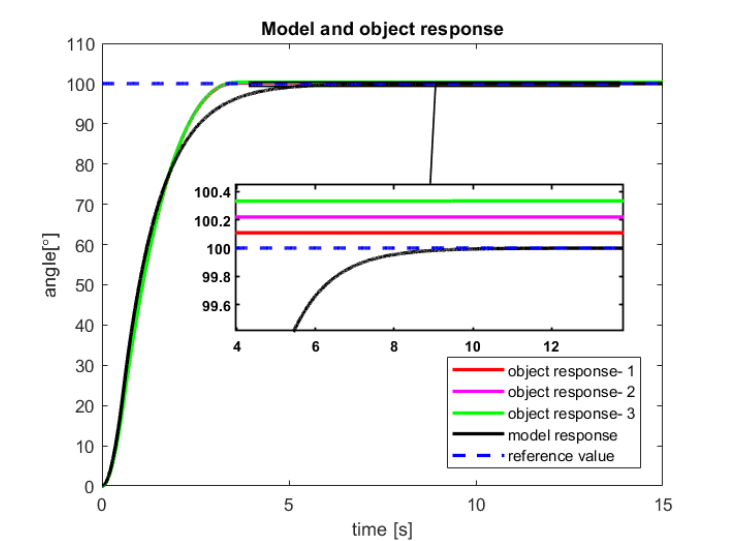
Figure 10. The received angular position of the model and the sensor-aided object—results of the three attempts with 100 ◦ reference value (source: authors).